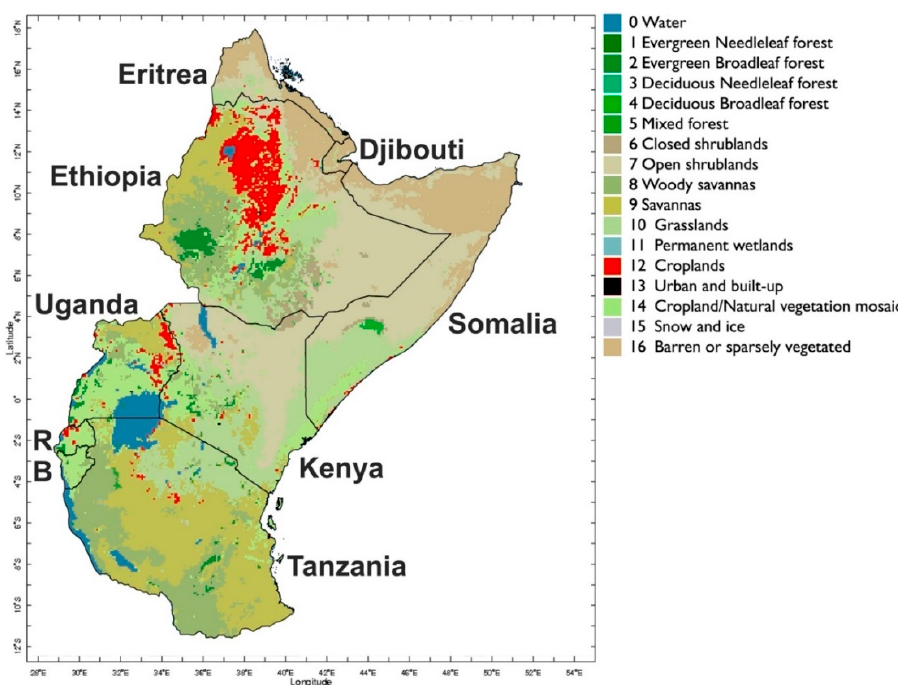
Figure 2. MODIS Moderate Resolution Spectroradiometer (MCD12Q1) Land Cover Dataset (500 m spatial resolution); R = Rwanda, B = Burundi; pixels that classify exclusively as “cropland” are highlighted in